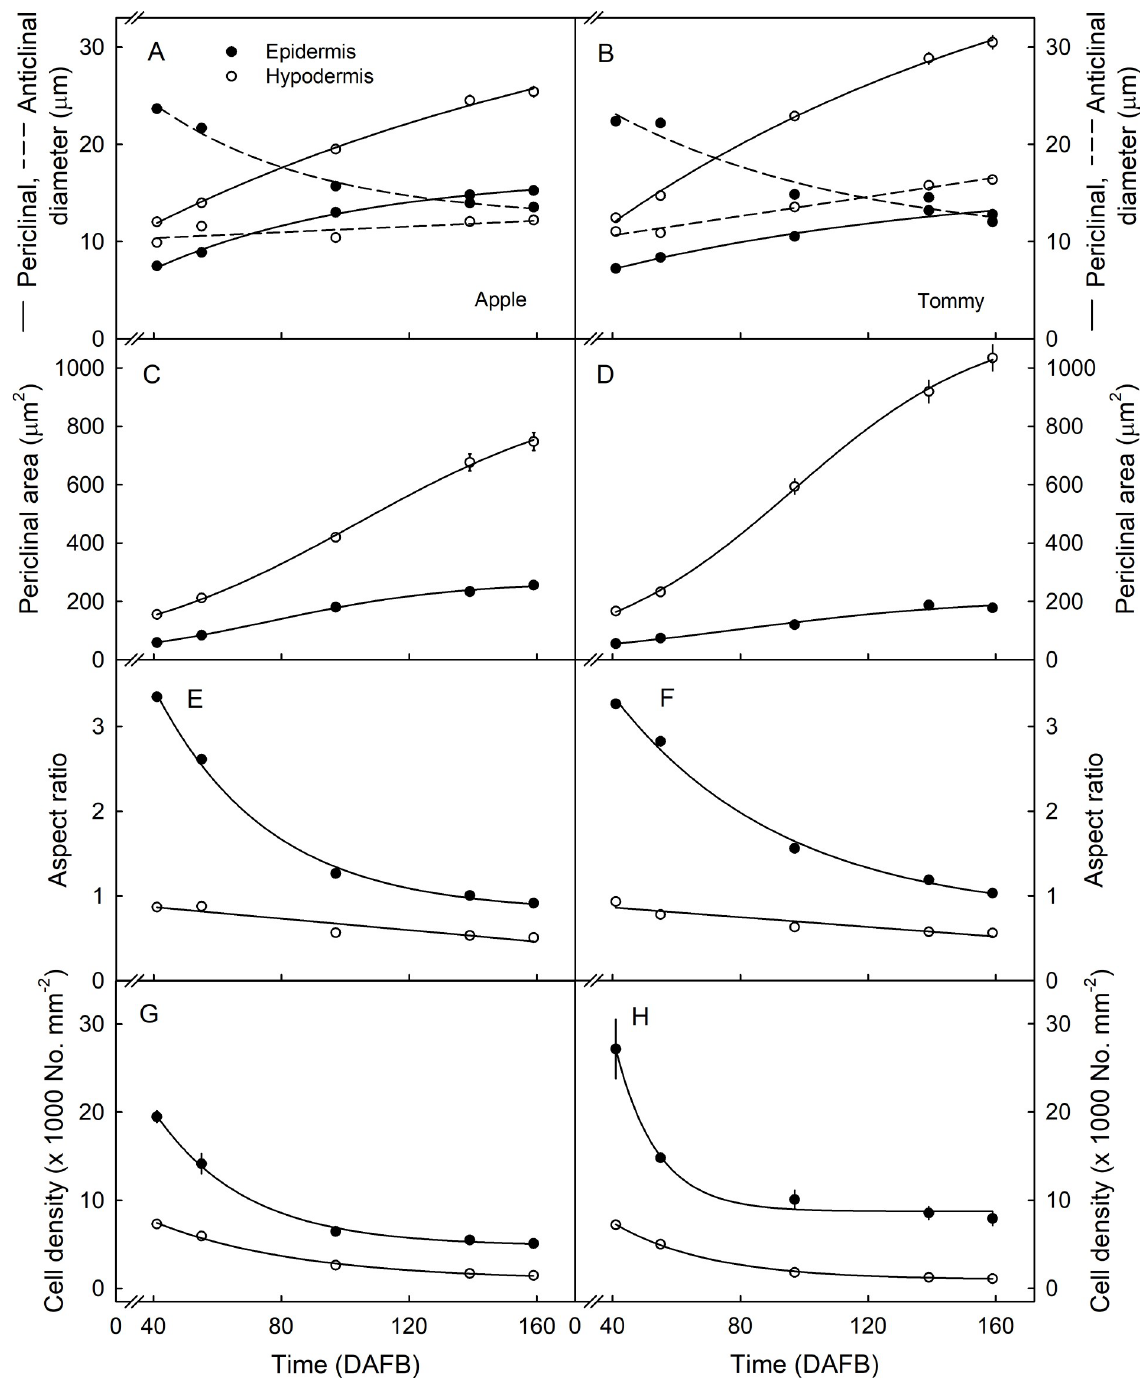
Fig 4. Developmental time course of change in anticlinal and periclinal diameters (A,B), periclinal area per cell (C,D), anticlinal aspect ratio (E,F) and number of epidermal and hypodermal cells per unit fruit surface area (G,H) of ‘Apple’ (A,C,E,G) and ‘Tommy Atkins’ (B,D,F,H) mango. The anticlinal aspect ratio was calculated as the anticlinal diameter divided by the periclinal diameter. The periclinal surface area of a cell was calculated as the square of cell periclinal diameter. The x-axis scale is in days after full bloom (DAFB). Data represent means ± SE. The number of individual fruit replicates was